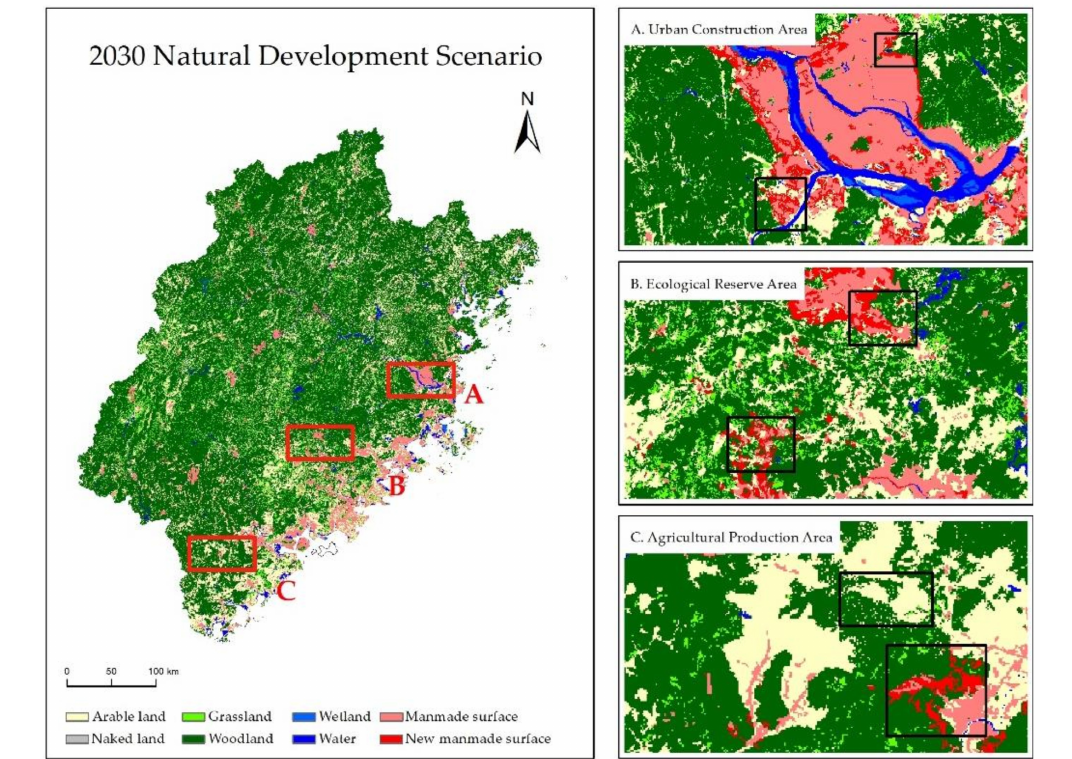
Figure 3. Land-use simulation map of Fujian Province under natural development scenario in 2030.